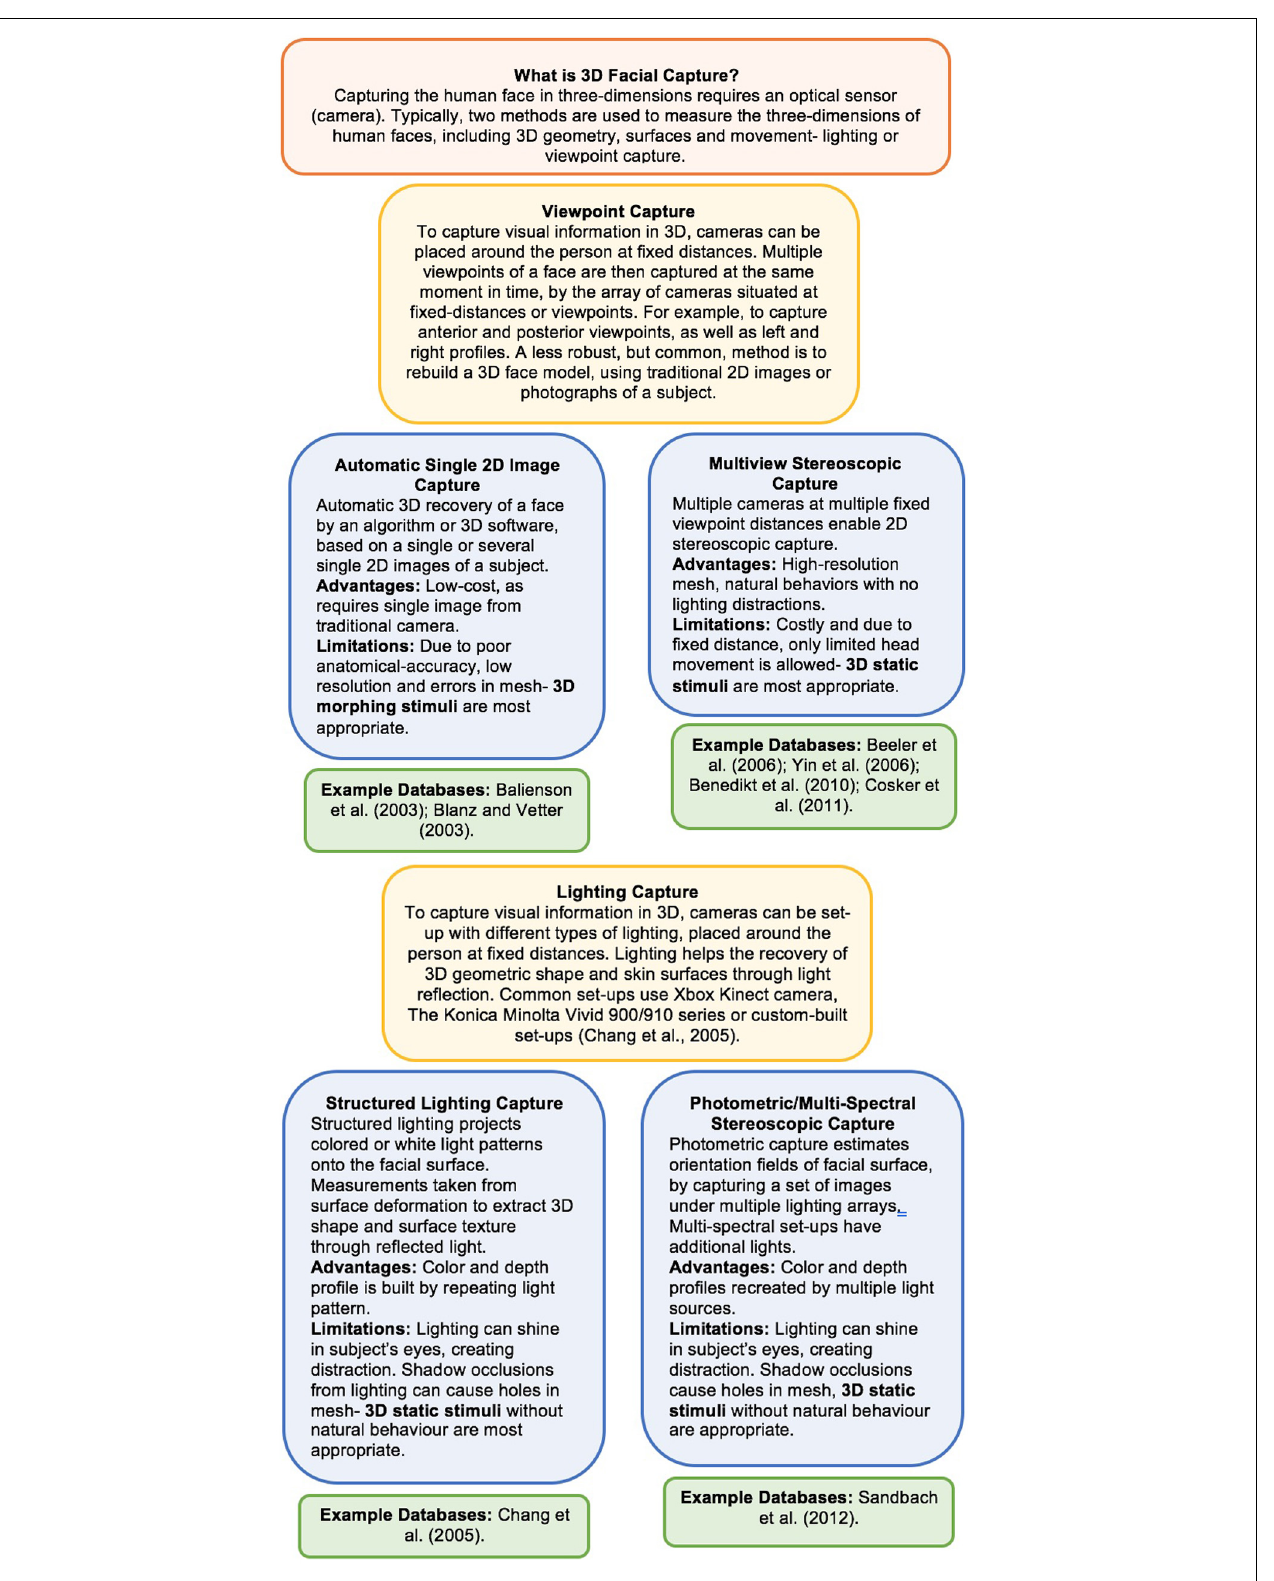
FIGURE 1 | Techniques of lighting and viewpoint capture used in highly cited 3D + 4D facial databases. See comprehensive review of capture techniques by Sandbach et al. (2012) and Table 1 in Zollhöfer et al. (2018).